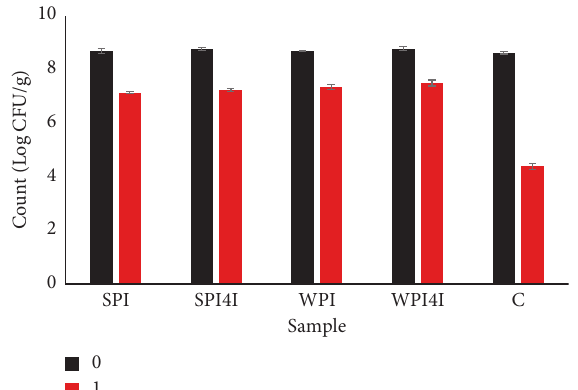
Figure 6: Effect of penicillin (0 and 1 µ g/mL) on the viability of L. reuteri encapsulated within different wall materials; SPI (soy protein isolate 20%), SPI4I (soy protein isolate 20%+inulin 4%), WPI (whey protein isolate 20%), WPI4I (whey protein isolate 20% +inulin 4%), and C (free